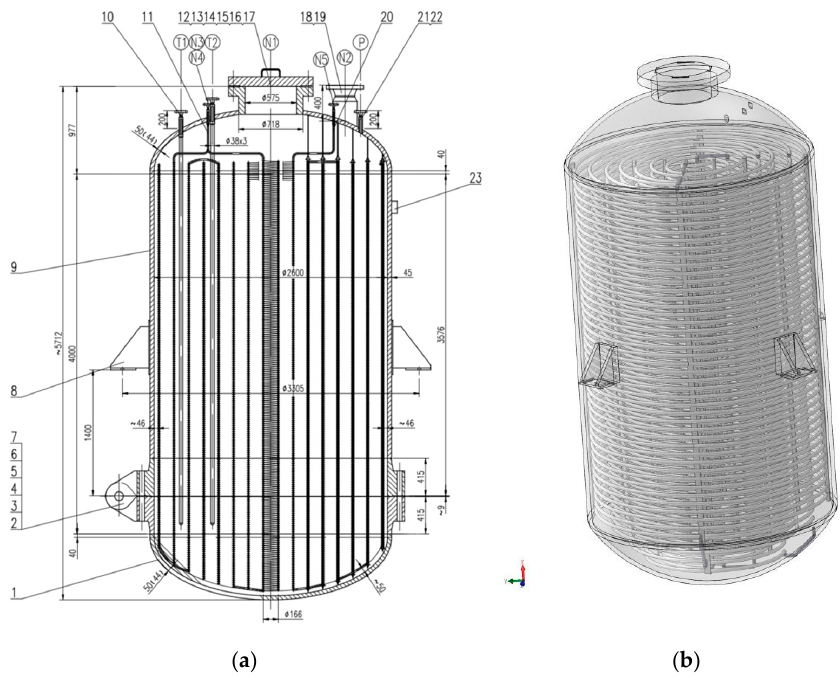
Figure 2. Reactor design diagram. ( a ) Reactor section view; ( b ) 3D model of the reactor.